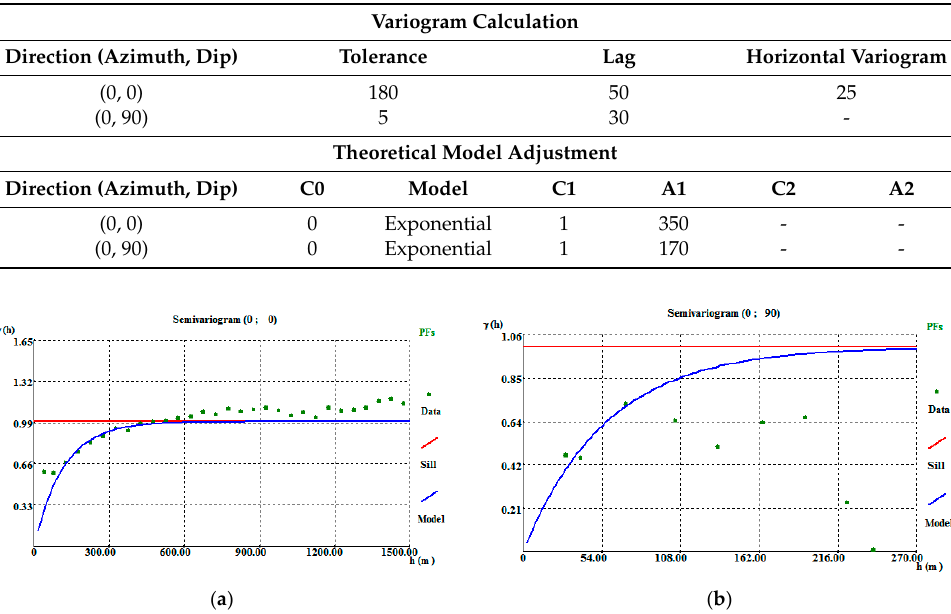
Figure A7. Borehole VP directional variograms: ( a ) horizontal variogram; ( b ) vertical variogram. The regularization was performed on a 50 m × 50 m × 30 m grid. Table A8. Calculation and adjustment parameters for stope VP variograms.